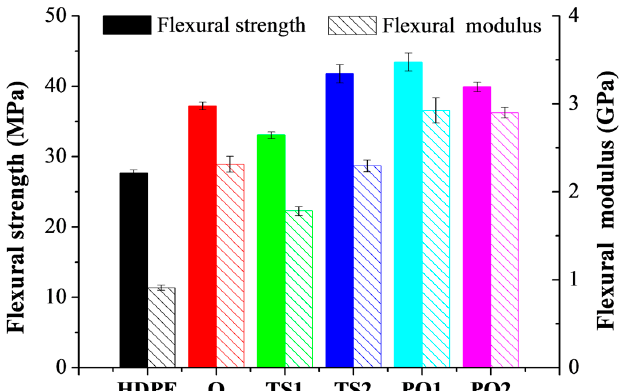
Figure 5. Flexural strength and modulus of pulp fiber/HDPE composites. Composite O: wet pulp fiber/HDPE mixture was dried by oven. Composite TS1: wet pulp fiber/HDPE mixture was dried by twin-screw extruder. Composite TS2: mixture TS1 was melt-extruded again. Composite PO1: wet pulp fiber/HDPE mixture was dried by prepressing and oven. Composite PO2: mixture PO1 was melt-extruded again.